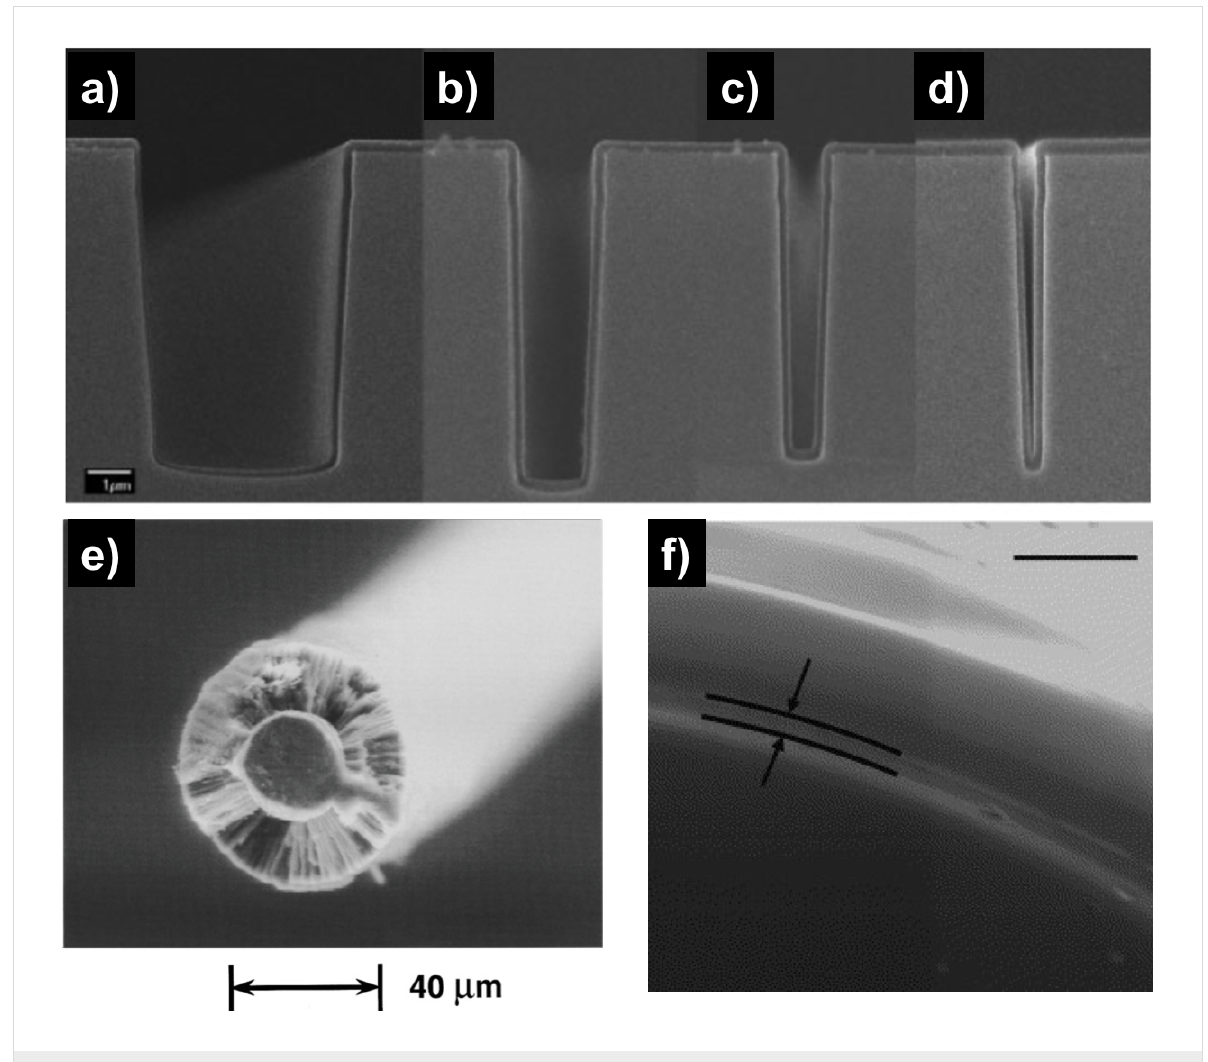
Figure 6: SEM images of iCVD pEGDA on micro-trenches with aspect ratios of a) 1.4 b) 3.5, c) 5.5 and d) 8.4. e) Cross-sectional SEM of 25 µm stainless-steel wire with 16 µm fluoropolymer coating formed via iCVD. f) iCVD pDMAMS on nylon fiber ion beam ablated to reveal substrate, scale bar is 1 µm. Parts a), b), c) and d) reprinted with permission from [25], copyright 2010 Wiley. e) Reprinted with permission from [26], copyright 1996, AIP Publishing LLC. f) Reprinted with permission from [27], copyright 2007,